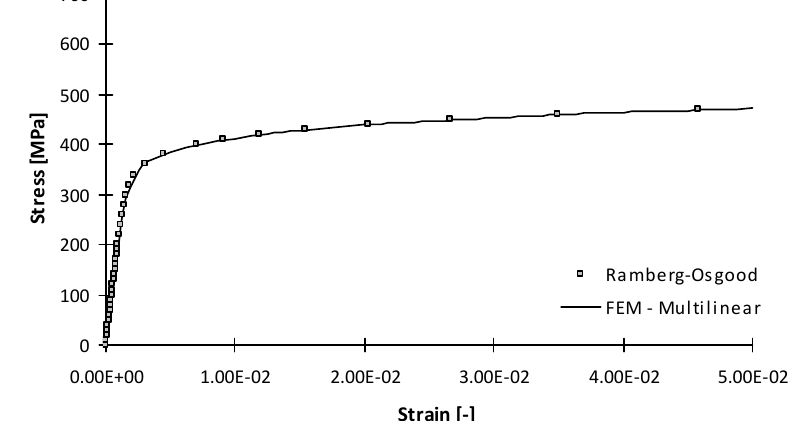
Figure 9: Cyclic curve of the S355 steel.